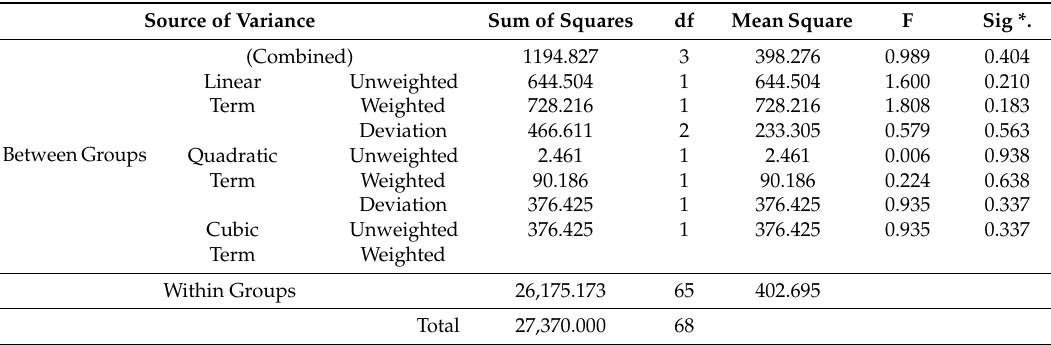
Table 2. ANOVA of Houston Habitat